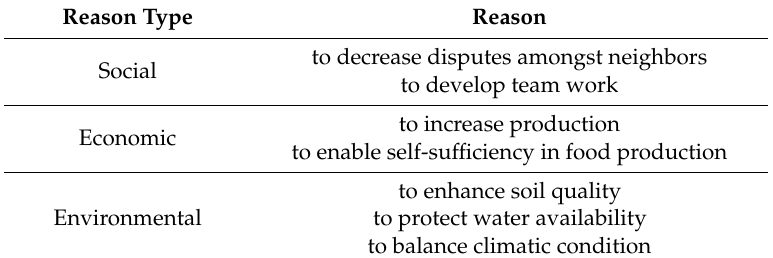
Table 1. Major reasons why policies are needed to counter land